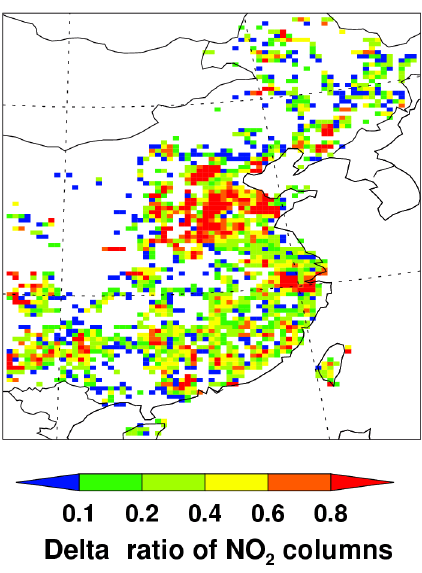
Figure 4. The distribution of ( (cid:127) GOME-2 /(cid:127) m0930 ) − ((cid:127) OMI /(cid:127) m1330 ) over eastern China for August